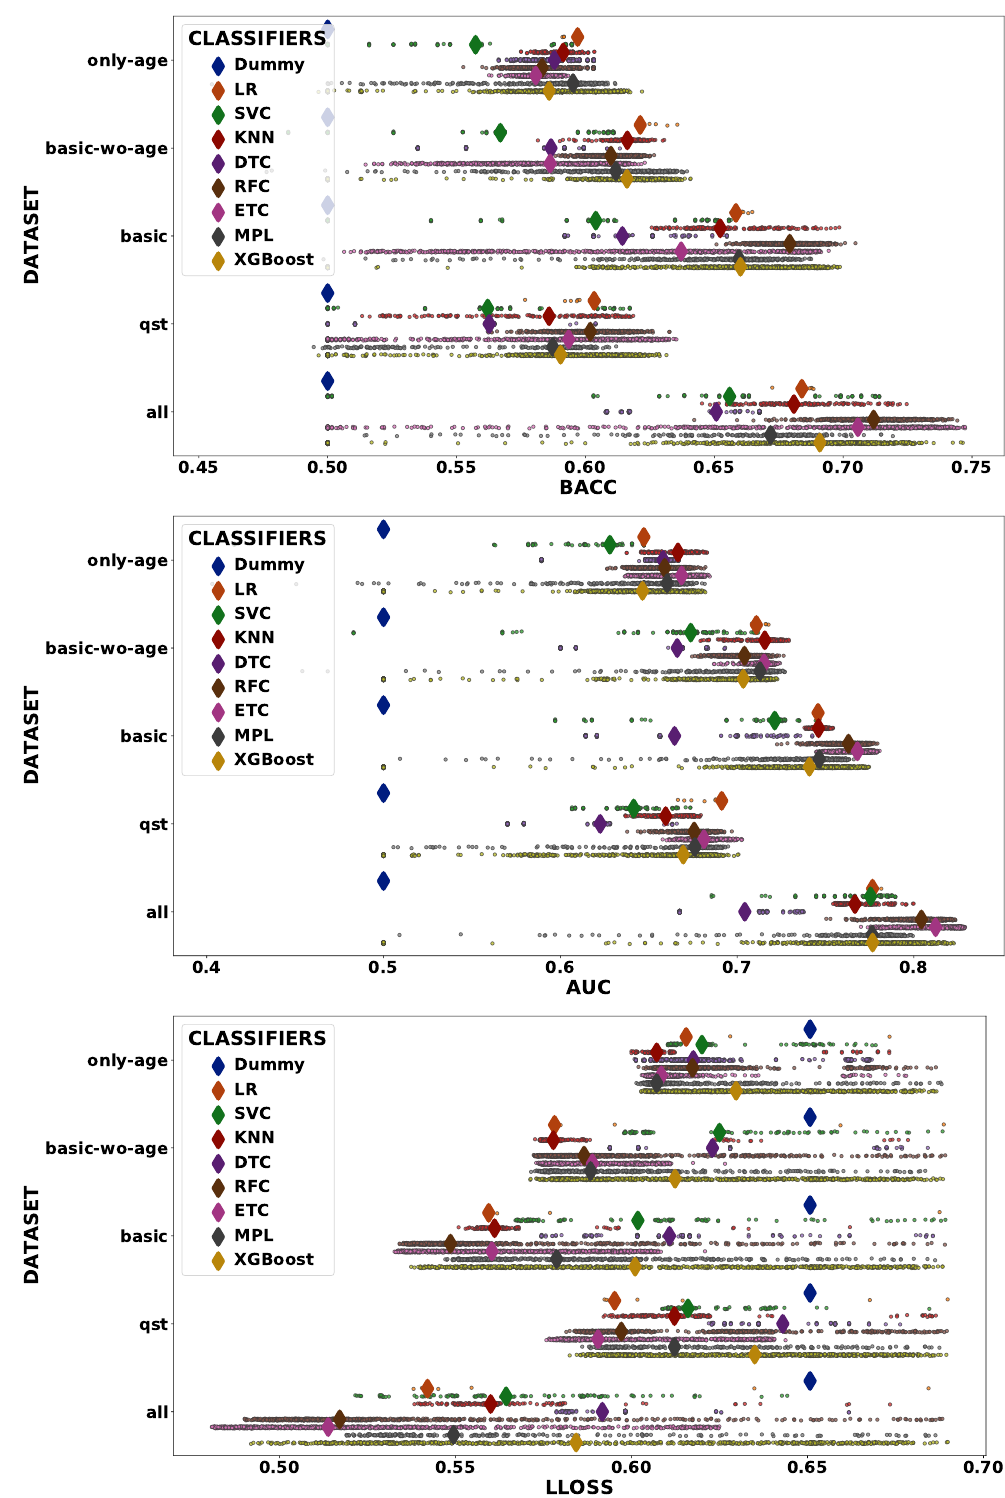
Figure 5. Strip plot for the BACC ( top ), AUC ( middle ), and LLOSS ( bottom ) grouped by dataset (vertical axis) and classifier type (colors). Each point represents one classifier with a specific hyper-parameter configuration, while the diamonds represent the medians of these